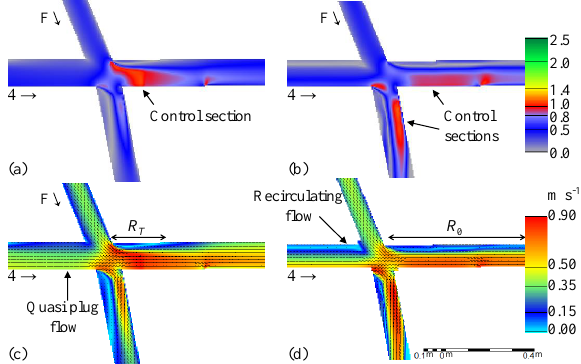
Figure 10. Velocity fields computed with (a, c) and without (b, d) the turbulence model for tests Q020-W050 (a, b) and Q100- W050 (c, d) . Grid size: 5mm.